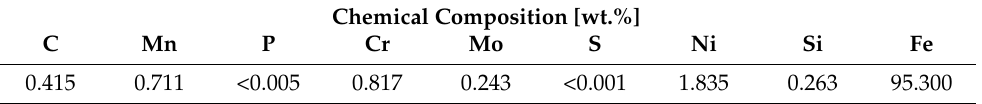
Table 3. Chemical composition of the substrate according to measurements (Q4